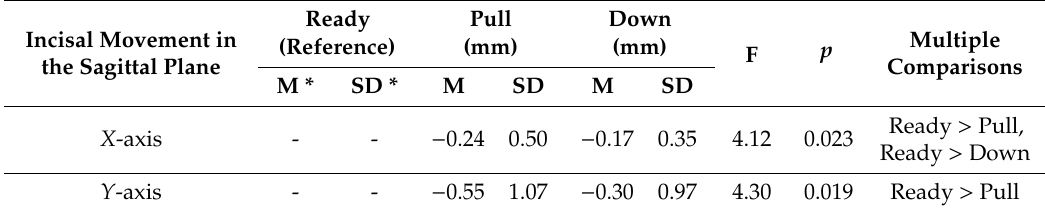
Table 1. Jaw movements during the steps of the deadlift (Ready, Pull, Down).